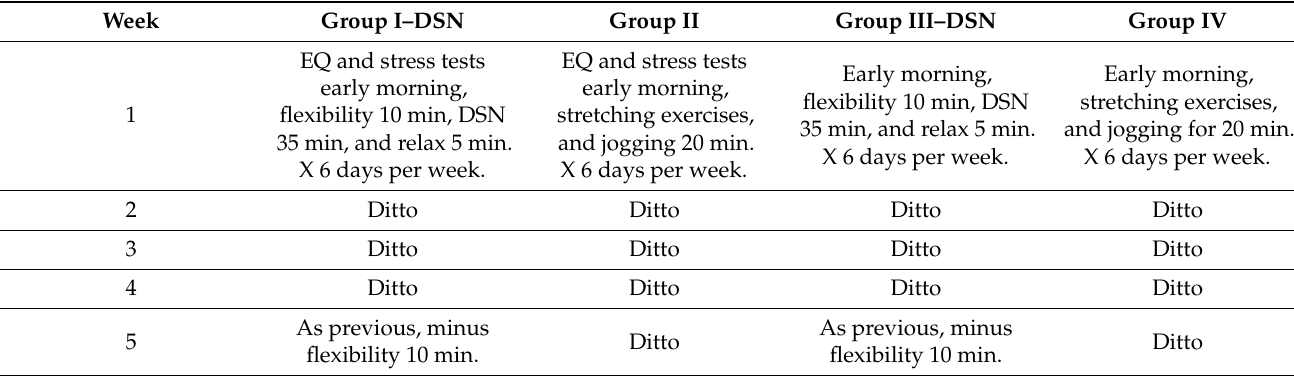
Table A1. Sequence of events in the protocol of Sun Salutations